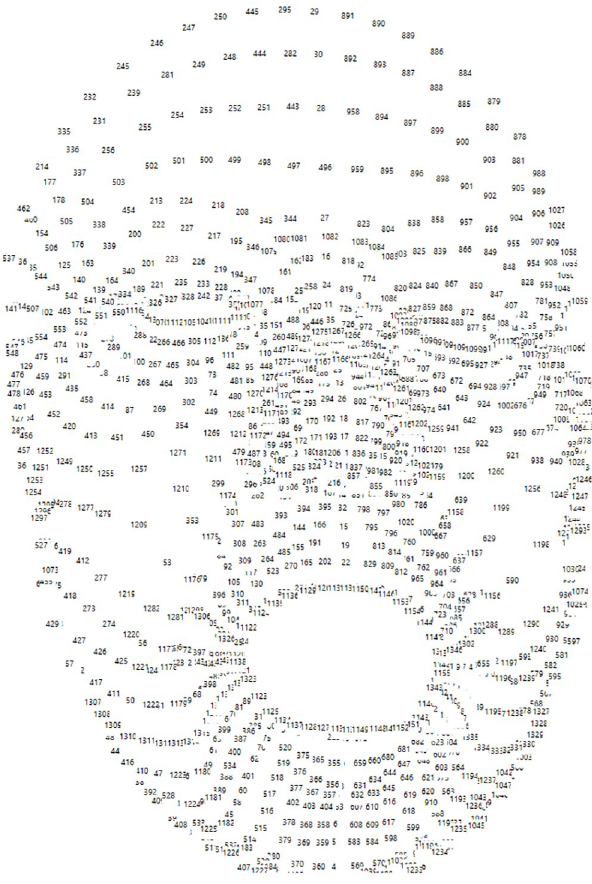
Fig 10. 1347 facial point detected by Kinect v2 sensor and Kinect HD Face API.